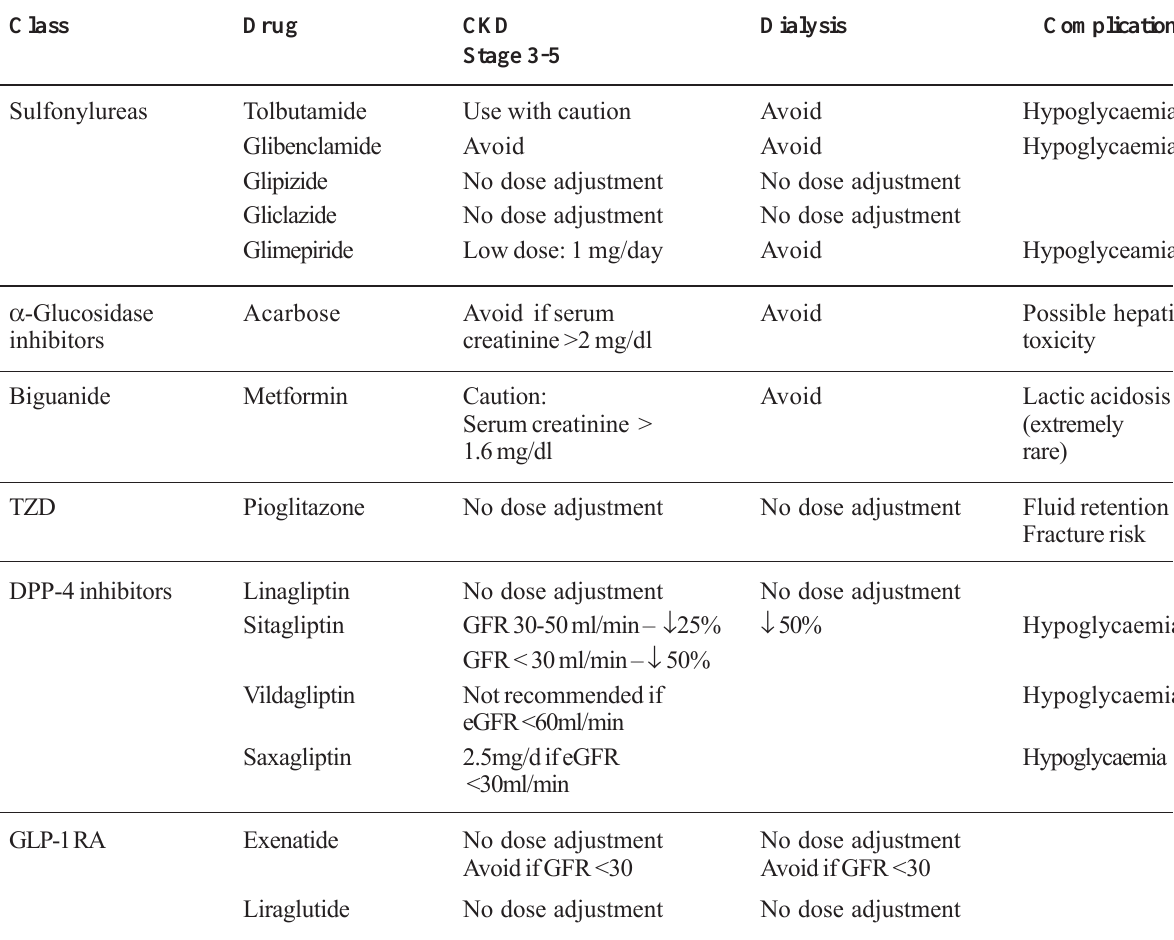
Table 4. Oral agents in